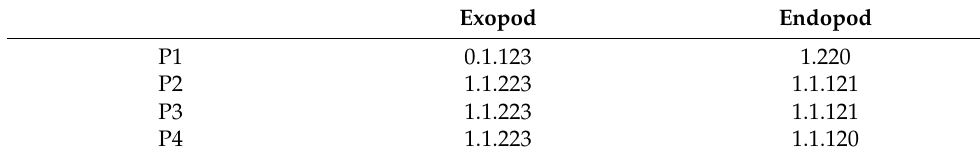
Table 1. Armature formulae of legs